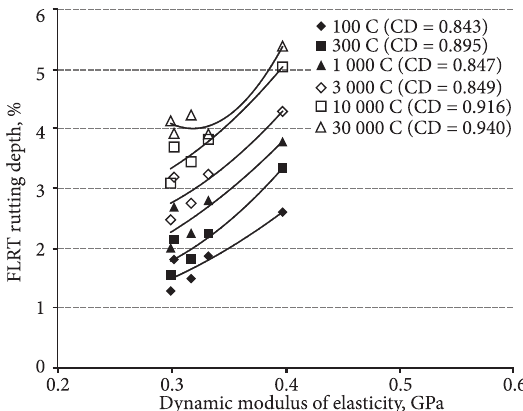
Fig. 7. Good to excellent relationships between dynamic modulus and FLRT rutting depth ( f = 0.5 Hz, T = +46.1 o C)